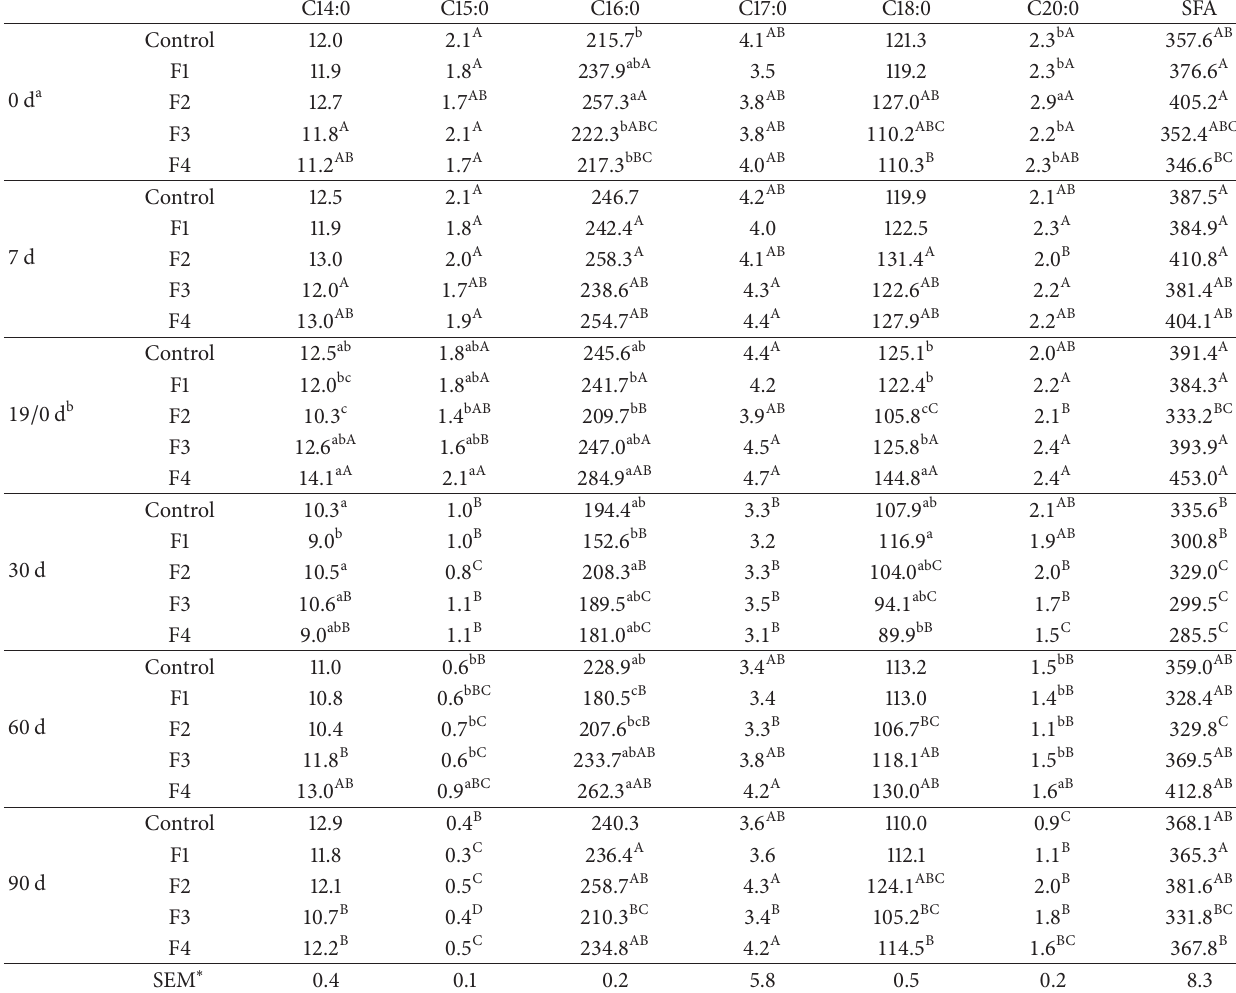
Table 2: Content of saturated fatty acids (SFA) in the lipid fraction (mg/g fat) during curing process and storage of salamis with NaCl reduced or replaced by KCl and/or CaCl 2